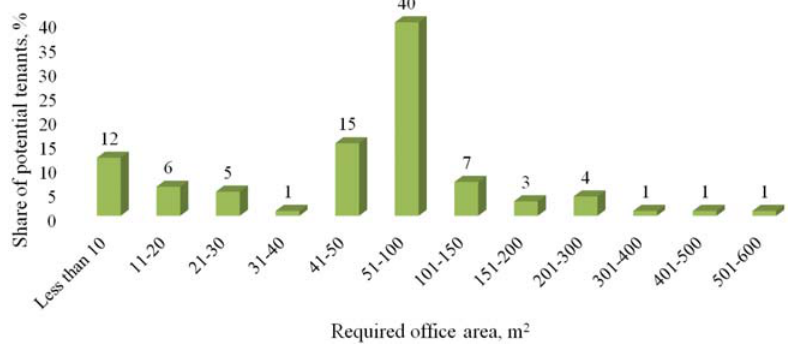
Fig. 4. Office space preferences’ distribution